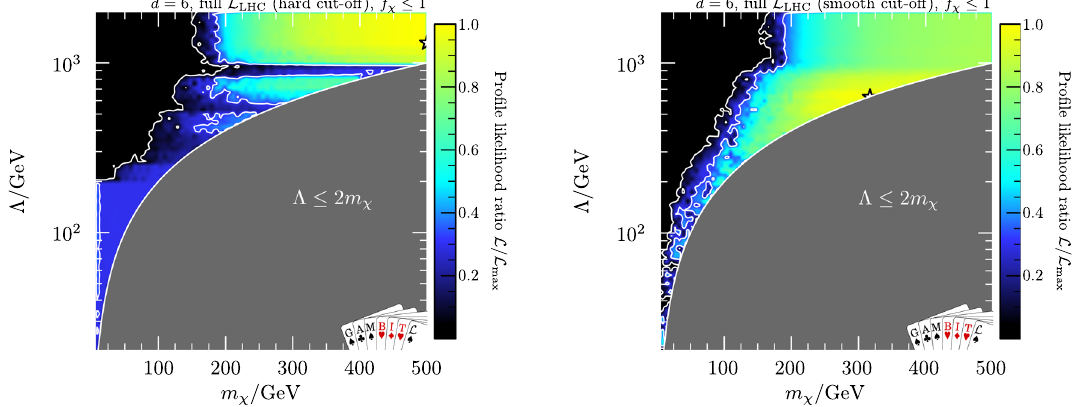
Fig. 8 Profile likelihood in the m χ – (cid:2) parameter plane when considering only dimension-6 operators and including the full LHC likelihood. In the left (right) panel, we impose a hard (smooth) cut-off in the predicted missing energy spectrum for / E T > (cid:2) (see text for details)